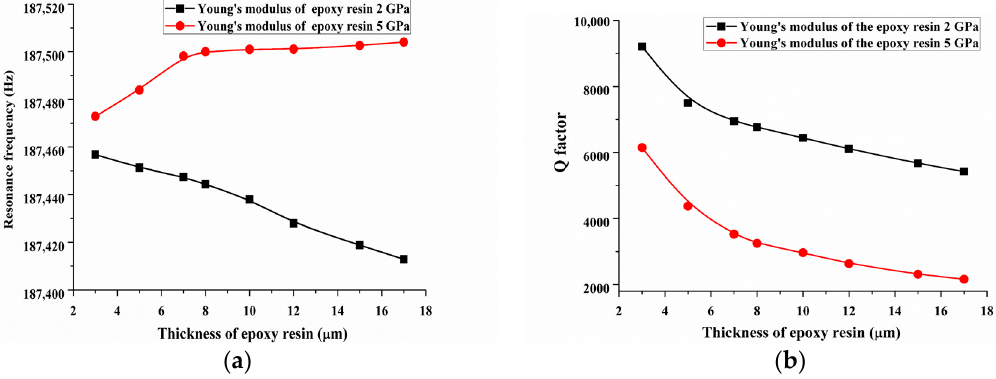
Figure 14. ( a ) Resonance frequency and ( b ) Q -factor with an increase of the Young’s modulus and